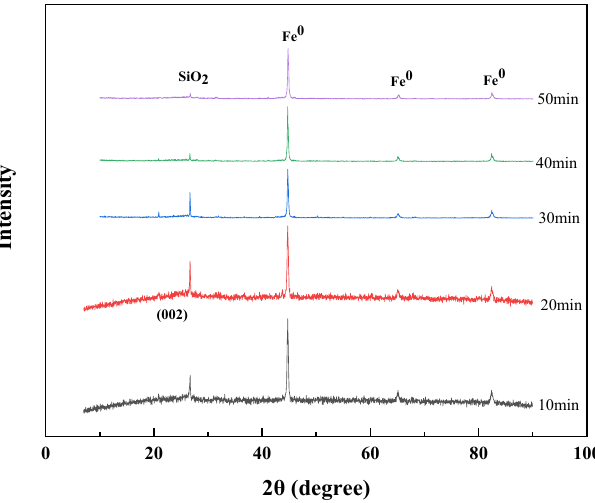
Figure 9. XRD pa tt erns of fi llers with di ff erent sintering times. Figure 9. XRD patterns of fillers with different sintering times.